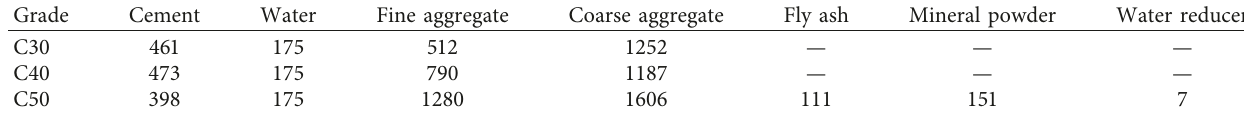
Table 1: Contents of plain concrete (unit: kg/m 3